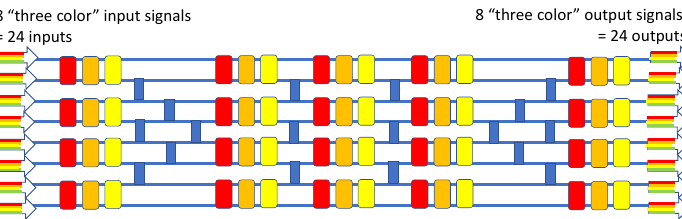
Figure 13. Block diagram of the 8 × 8 × 3λ wavelength-selective switch.